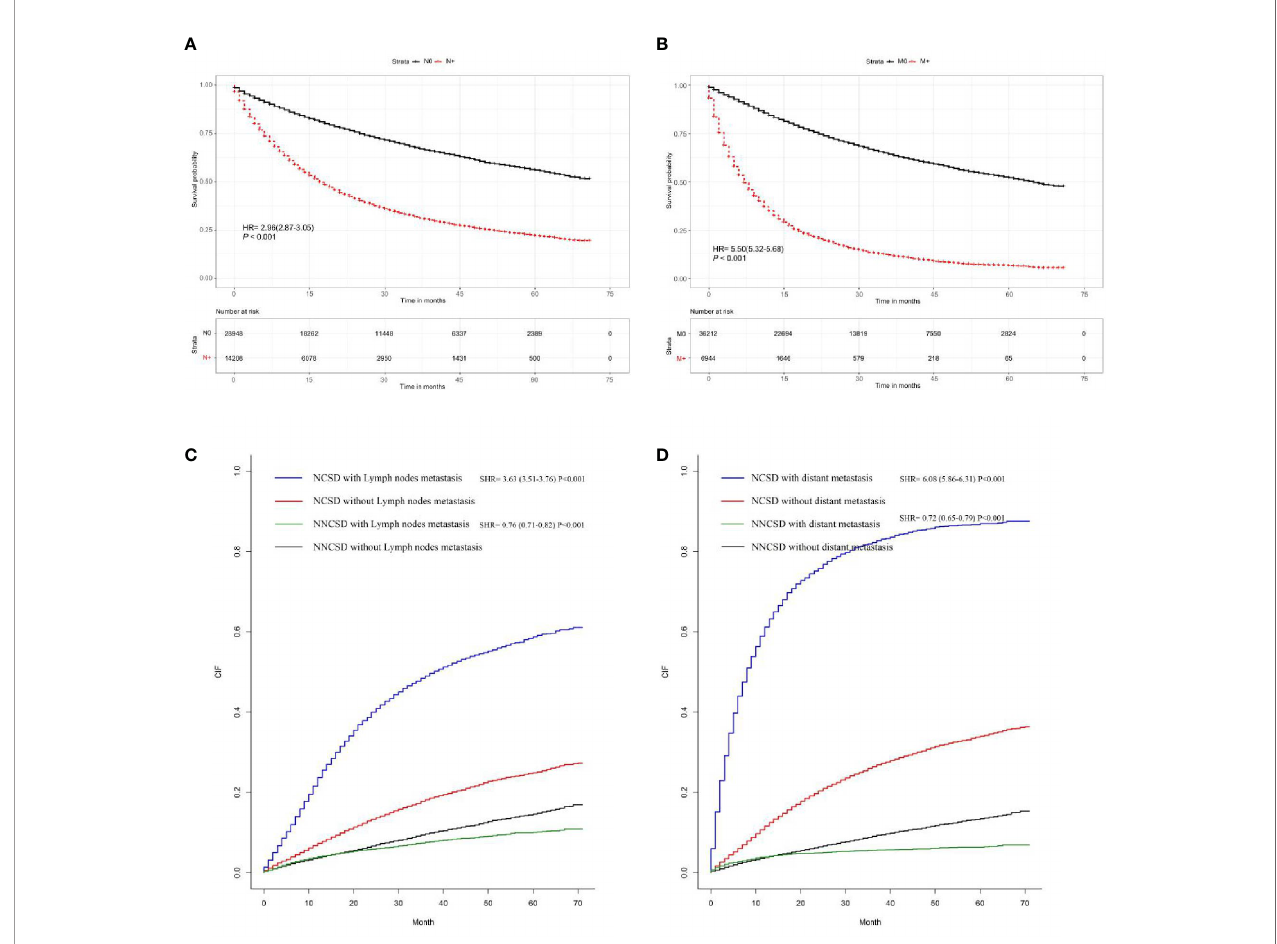
FIGURE 7 | The survival rate of T1-2 NSCLC patients was evaluated by the presence or absence of LNM and DM; the results showed that LNM and DM are closely related to survival rate (A, B) . The cancer-speci fi c survival rate of T1-2 NSCLC patients was evaluated by the presence or absence of LNM and DM; the results demonstrated that LNM and DM are closely correlated with cancer-speci fi c survival rates (C, D)